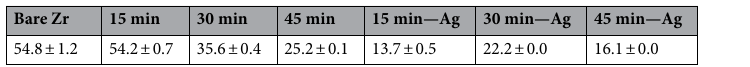
Table 2. Average contact angles of the surfaces.